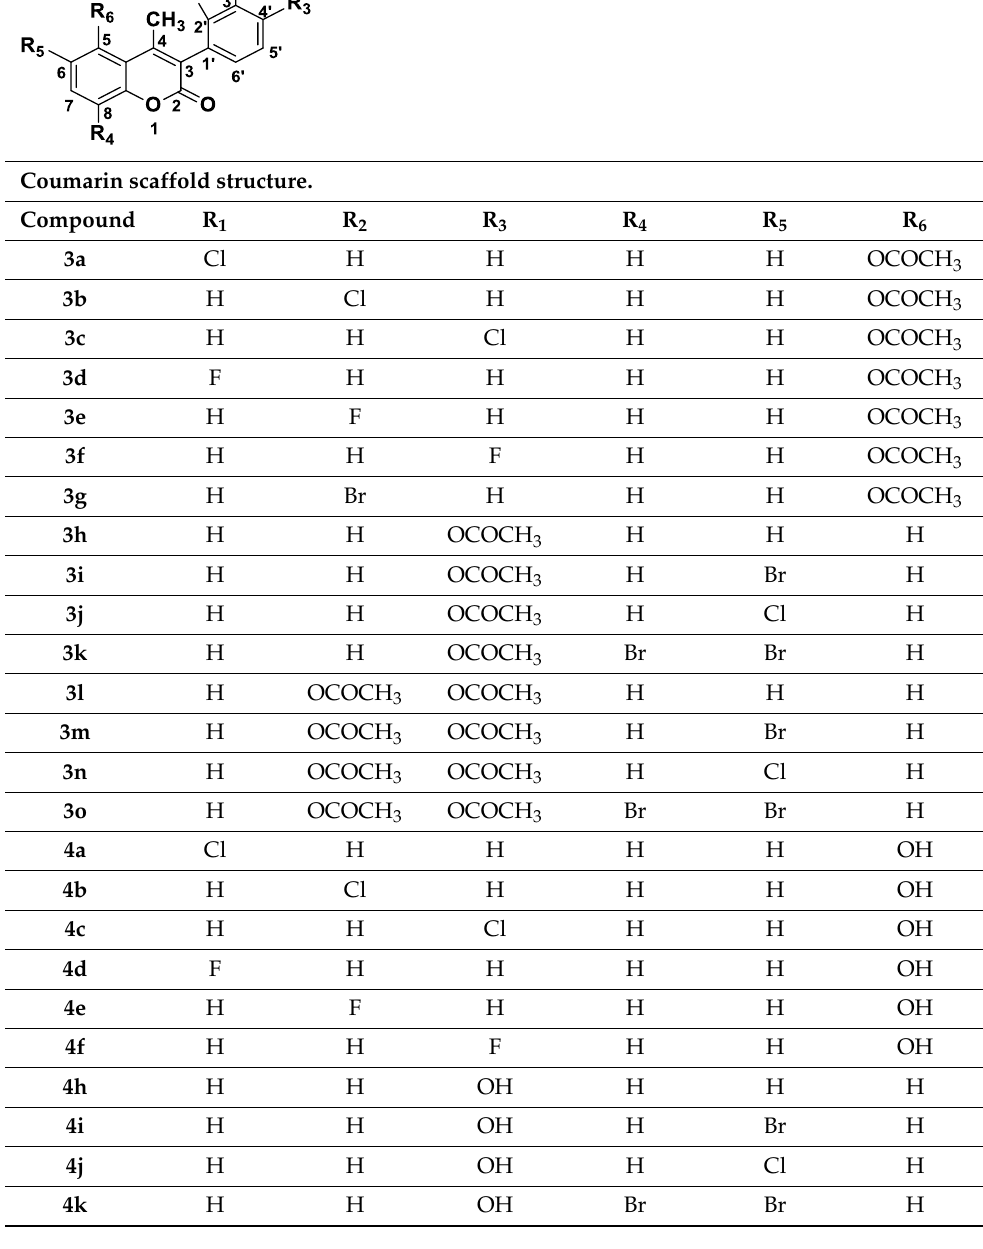
Table 1. Substituents of the coumarin derivatives.